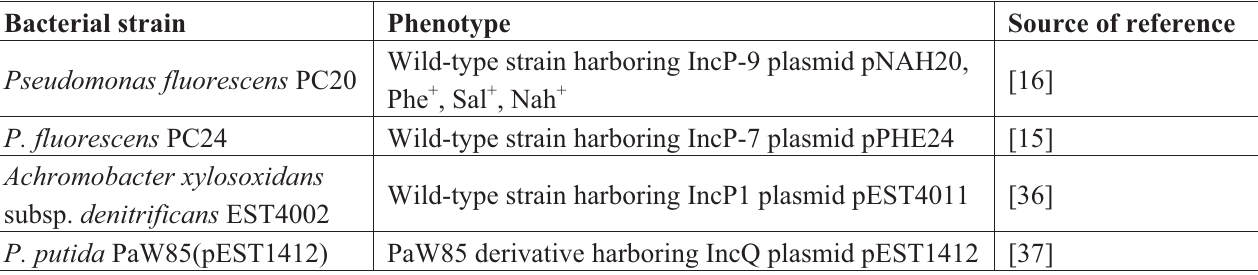
Table 5. Reference bacterial strains used in this